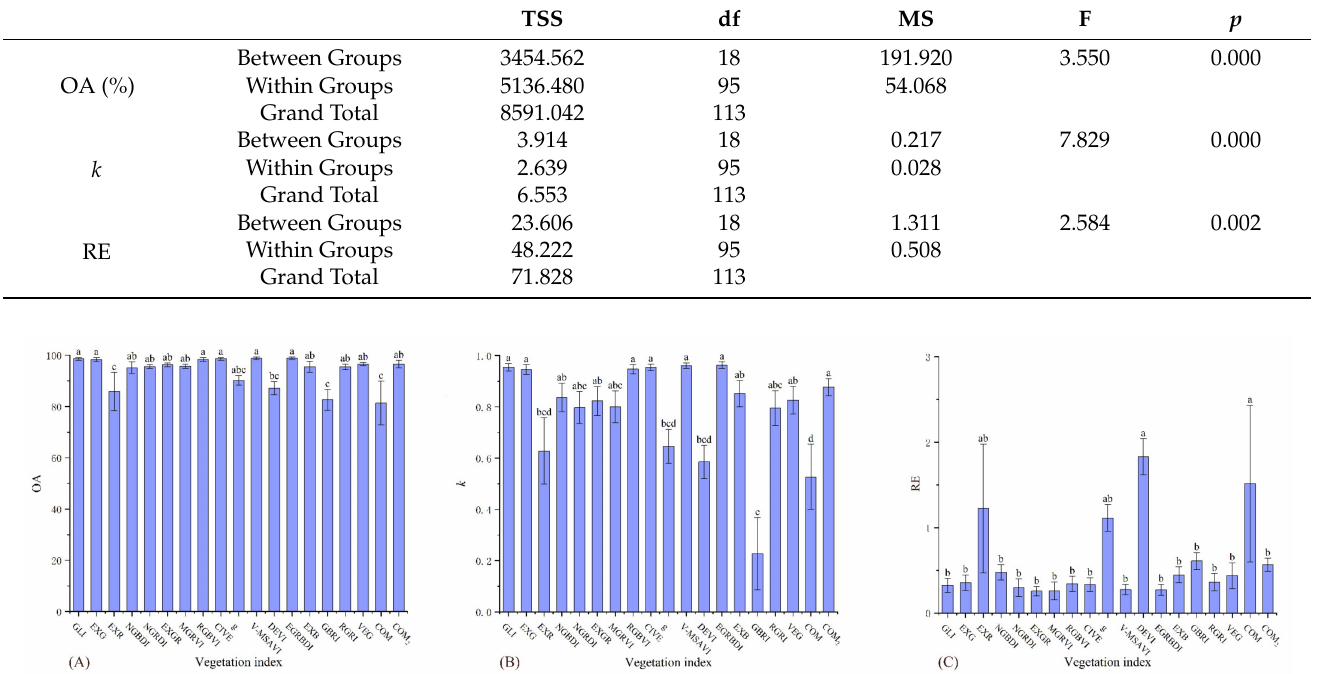
Table 5. OA, k , and RE differences of 19 vegetation indices on the high desertification grade.